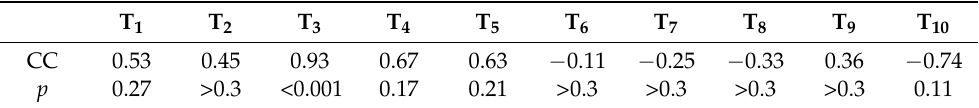
Table 2. The correlation coefficient (CC) values and their significance levels ( p ) between SSN and 10 temperatures (T 1 ~T 10 ). T 1 T